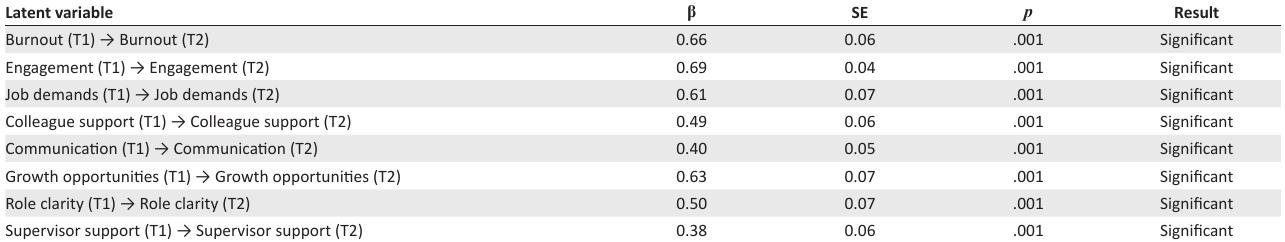
TABLE 3 : Summary of control paths with relevant statistics reported. Latent variable